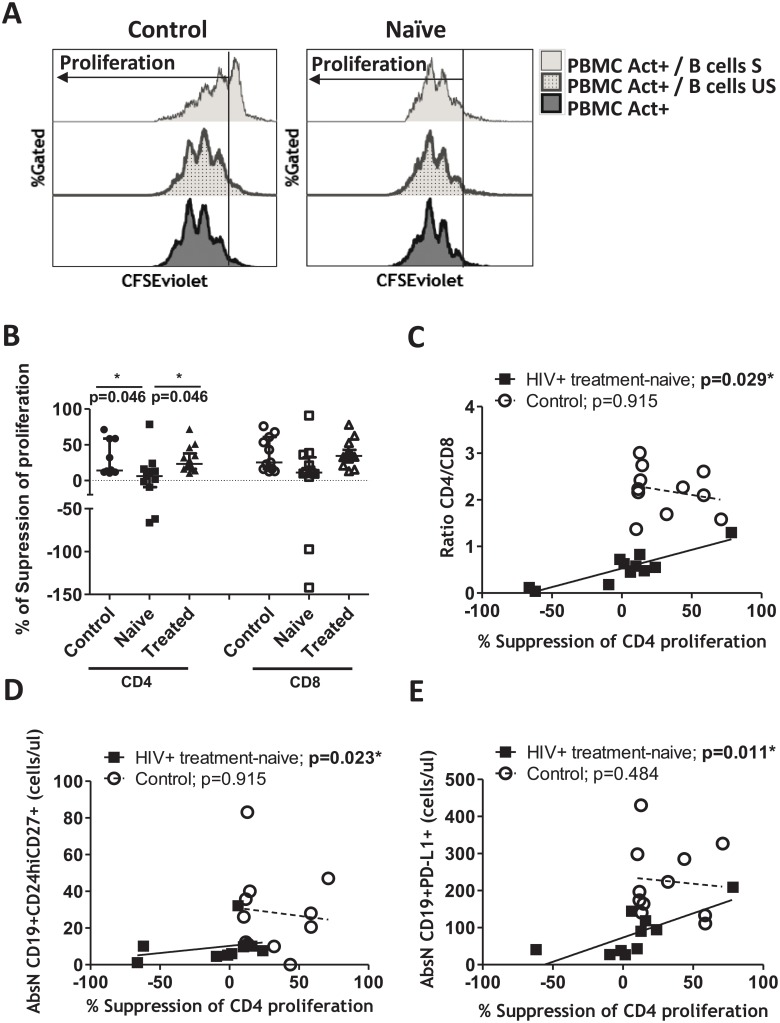
Suppression of PBMC proliferation.B cells were isolated and stimulated with CD40L/LPS/CpG for 2 days. Unstimulated (US) and stimulated (S) B cells were then washed and co-cultured with autologous CFSE-labeled PBMCs for 3 days. (A) Proliferation was followed in living cells as the loss of CFSE signal. Histogram plots showing the PBMC proliferation under anti-CD3/anti-CD28 activation, alone (PBMC Act+) or co-cultured with S or US B cells. Histograms representing one healthy (Control) and one HIV+ treatment-naïve individuals (Naïve) are shown. (B) Percentage of suppression of proliferation of CD4+ or CD8+ T cells was calculated as follows: (100-(proliferation of CFSE-labeled T cells in co-culture with stimulated B cells*100/ proliferation of CFSE-labeled T cells in co-culture with unstimulated B cells)). Negative values corresponded to an increase in proliferation. Medians ± IQRs are represented. (C) Correlation between percentage of suppression of proliferation of CD4+ T cells and CD4/CD8 ratio in HIV+ treatment-naïve and healthy individuals. (D) Correlation between percentage of suppression of proliferation of CD4+ T cells and absolute numbers (AbsN) of CD19+CD24hiCD27+ in HIV+ treatment-naïve (Naïve) and healthy individuals. (E) Correlation between percentage of suppression of proliferation of CD4+ T cells and absolute numbers (AbsN) of CD19+PD-L1+ in HIV+ treatment-naïve (Naïve) and healthy individuals. Correlations were determined by Spearman’s rank correlation. * = p<0.05 when comparing conditions. Each symbol corresponds to an individual.